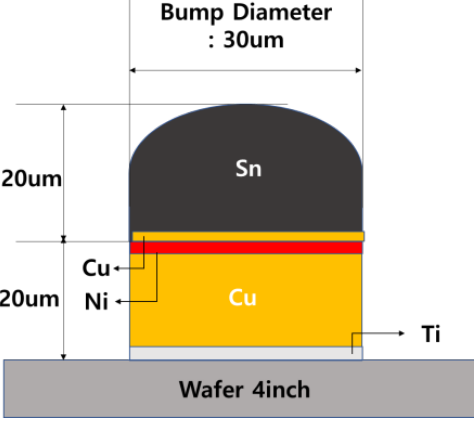
Figure 7. Pure Sn bump formation design with a diameter of 30 µm. (b) Results of pure Sn bump geometry formed by plating A 30 µ m pure Sn bump was formed with plating equipment as shown in Figure